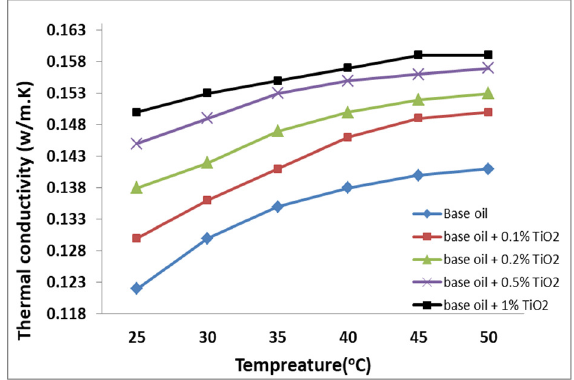
Fig. 8. Comparison of the thermal Conductivity between the parent oil and nano-lubricants at different temperatures and